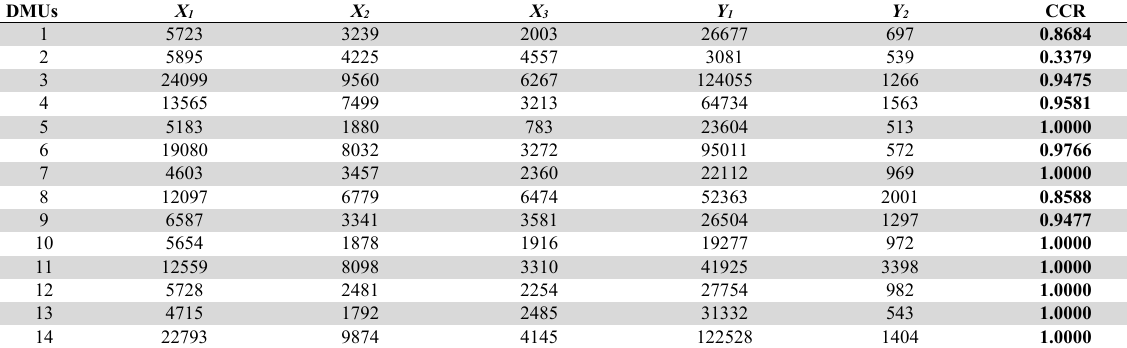
Data set of fourteen international passenger airlines